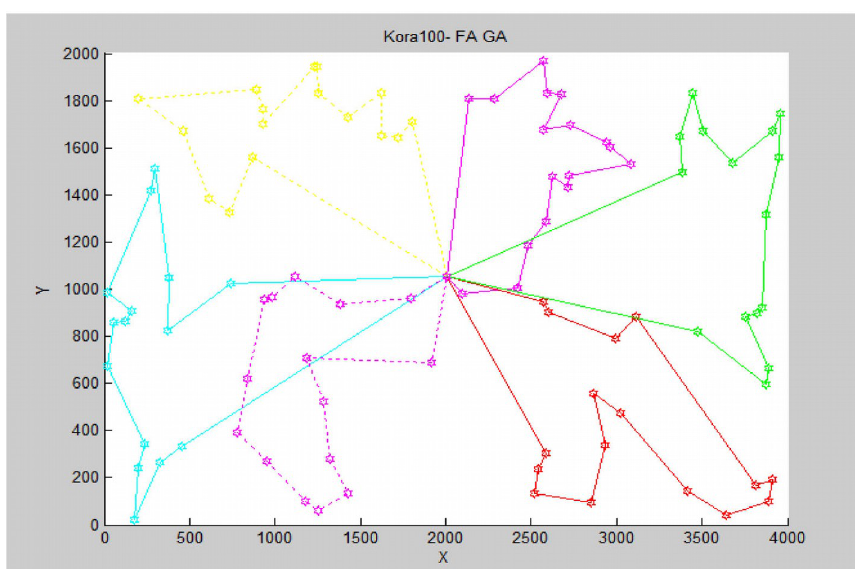
Figure 1. Clusters formed for the instance KorA100 by FA-GA (MATLAB output)